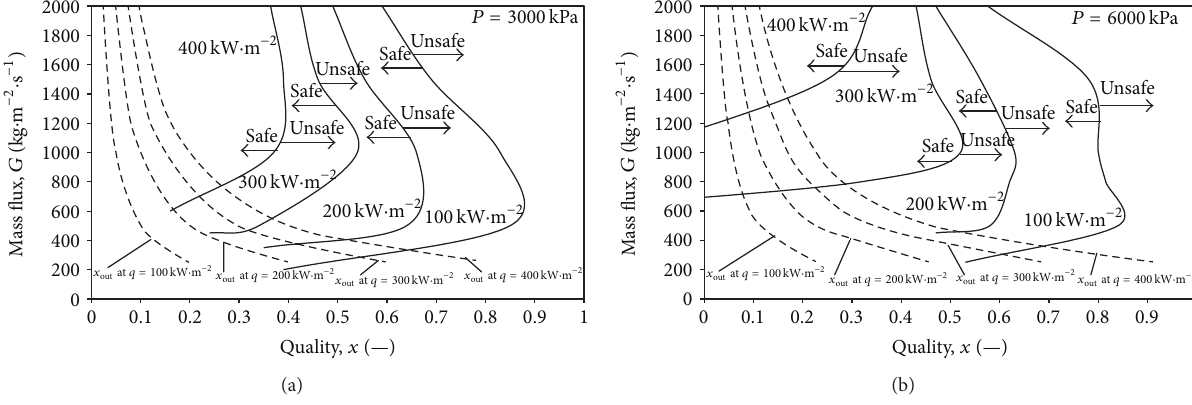
Figure 8: Safety limits of the operation of boiler for 50% allowable heat